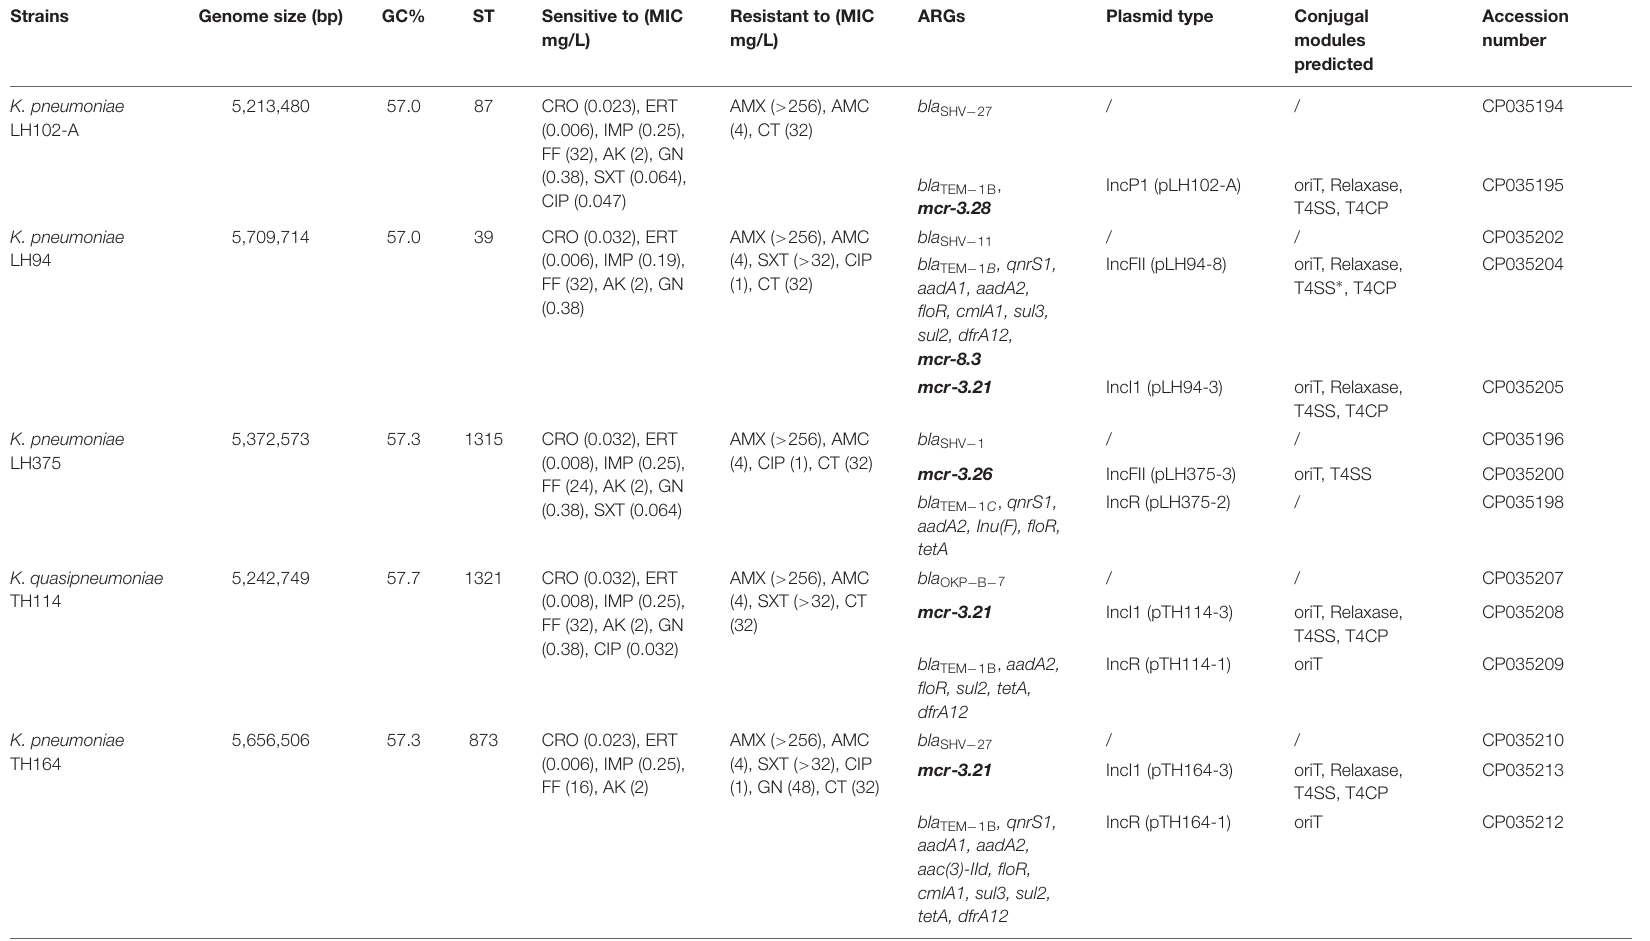
TABLE 1 | Characteristics of Klebsiella spp. strains analyzed in this study.